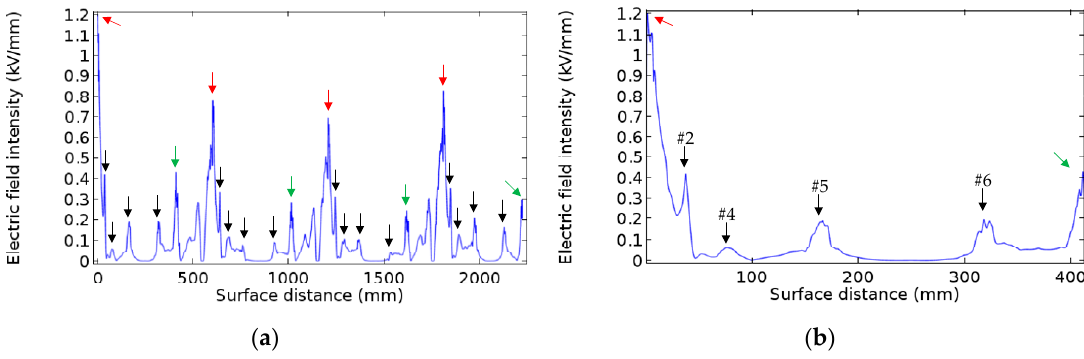
Figure 10. Electric field distribution along insulator string under clean and dry conditions: ( a ) insulator string; ( b ) No.1 insulator porcelain surface.